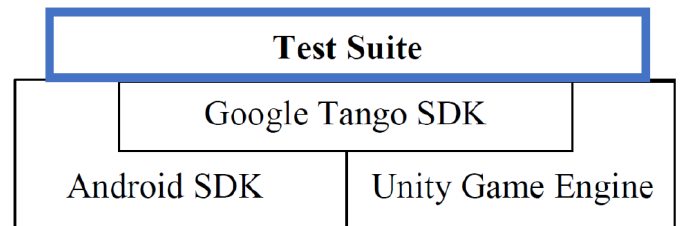
Figure 1. System support for the suite implementation.